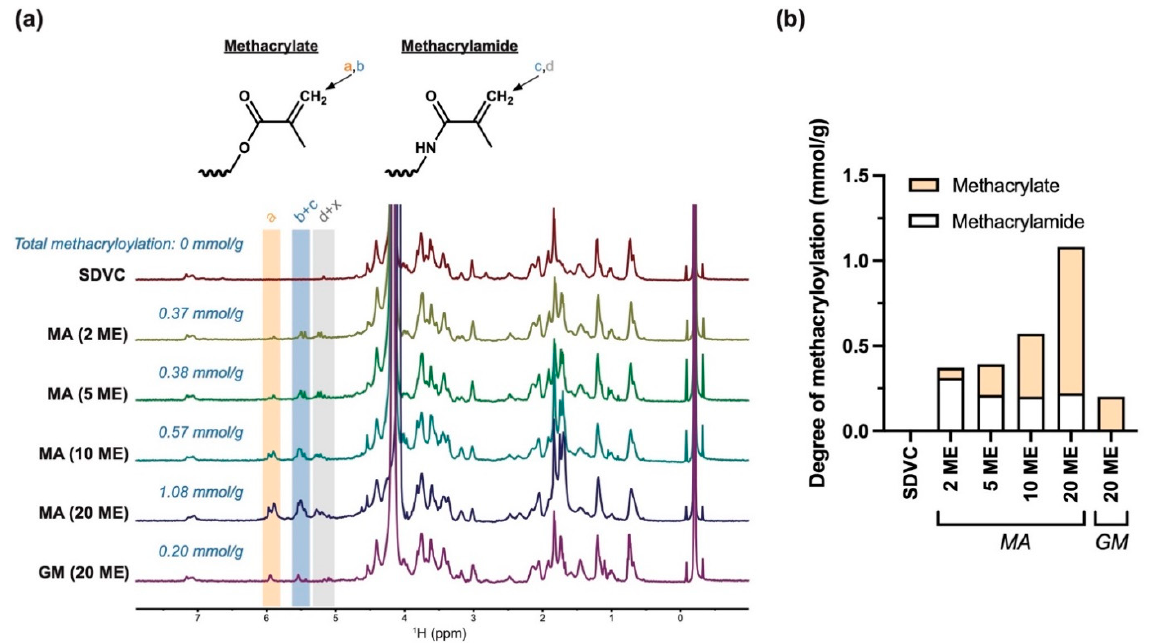
Figure 3. Solubilized cartilage functionalized with methacrylic anhydride had higher functionalization than glycidyl methacrylate. ( a ) The structures of methacrylates (i.e., functionalized hydroxyls/carboxyls) and methacrylamides (i.e., functionalized amines) are shown with the two CH 2 protons of methacrylates labeled as “a” and “b” and the two CH 2 protons of methacrylamides labeled as “c” and “d”, which correspond to the highlighted portions of the NMR spectra. The NMR spectra of SDVC and MeSDVC functionalized with different molar excesses (ME) of methacrylic anhydride (MA) (i.e., 2, 5, 10, 20 ME) and 20 ME of glycidyl methacrylate (GM) are shown. Total methacryloylation (in blue text) was determined via integration of the signals arising from one proton of the methacrylate and one proton of the methacrylamide (i.e., 5.40–5.65 ppm “b + c”, blue highlight), with normalization to the TMSP internal standard (–0.22 ppm). With increasing molar excesses of MA, there was increased total methacryloylation. ( b ) The proportion of methacrylate and methacrylamide content for each MeSDVC is shown. Methacrylate content was determined via integration of the signals from one proton of the methacrylate (i.e., 5.80–6.00 ppm, “a”, orange highlight). Methacrylamide content was calculated as the methacrylation subtracted from the total methacryloylation. Methacrylamide content was constant across the MA functionalized MeSDVC and the methacrylate content increased with an increased molar excess of MA. The GM did not have methacrylamide signals and did not appear to have functionalized amines.